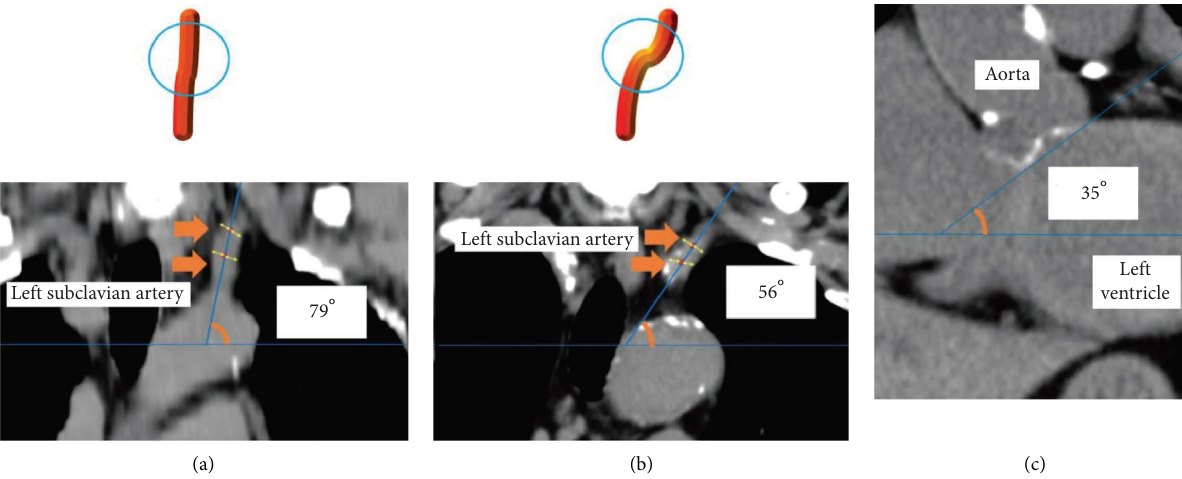
Figure 2: Representative schematic images (upper panels) and CTimages in the coronal view (lower panels) in patients with mild tortuosity (a) and severe tortuosity (b). (a) In a case of mild tortuosity, the angle of the left subclavian artery is 79 degrees. In this case, the time from sheath insertion to the frst balloon time was 20 minutes and total procedure time was 46 minutes, respectively. (b) In patients with severe tortuosity, the angle of the left subclavian artery was 55 degrees. In this case, the time from sheath insertion to the frst balloon time, the total procedure time, and the fuoroscopy time were longer than in case (a) (43 minutes and 97 minutes, respectively). (c) Te angle of the aortic root on the coronal view. Te details of the measurement method are shown in the text. LRA, left radial approach; PCI, percutaneous coronary